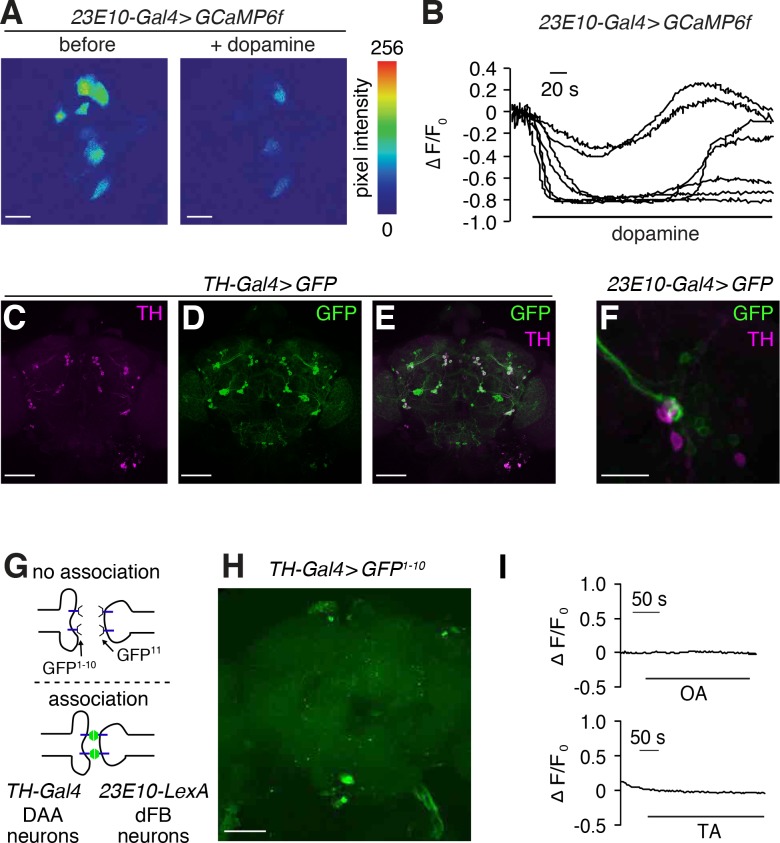
DAA arousal neurons regulate dFB neurons.(A) Representative images of GCaMP6f fluorescence in the soma of dFB (23E10-Gal4) neurons before and during bath application of 10 mM dopamine. The scale bar represents 20 µm. (B) Representative traces showing changes in GCaMP6f fluorescence (∆F/F0) in the soma of 7 dFB neurons soma before and during bath application of 10 mM dopamine. (C—E) Whole-mount brains expressing UAS-GFP under control of the TH-Gal4 immunostained with anti-GFP and anti-TH. The scale bars represent 60 µm. (F) Immunostaining of whole-mount brain expressing GFP in dFB neurons. Anti-GFP (green). Anti-TH (red) labels dopaminergic neurons. The scale bar represents 60 µm. (G) Cartoon showing the GRASP analysis shown in Figure 5C. (H) Negative control for GRASP analysis shown in Figure 5C. The scale bar represents 60 µm. (I) Representative traces showing lack of changes in syt::GCaMP6s fluorescence (∆F/F0) in dFB (AstAR1) neurons (23E10-Gal4 > syt::GCaMP6s) upon bath application of 10 mM octopamine (OA) and 10 mM tyramine (TA). 3—four independent samples were imaged.